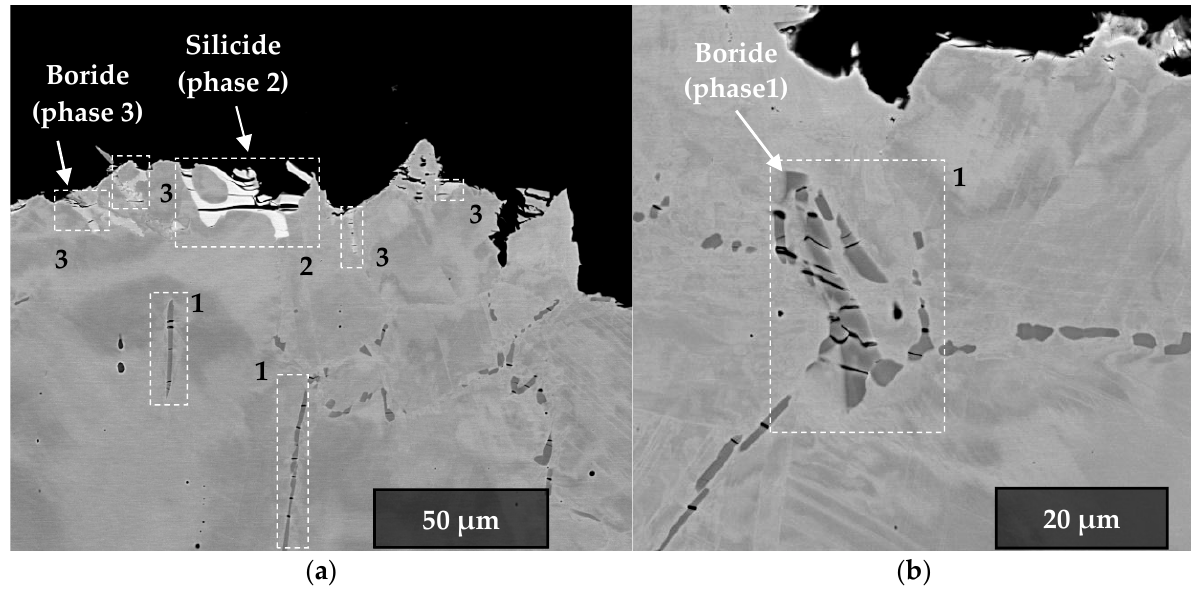
Figure 21. Cross ‐ section of ST20 15min , which shows the ( a ) fracture mechanism and ( b ) cracked borides inside the material after high ‐ speed tensile testing.